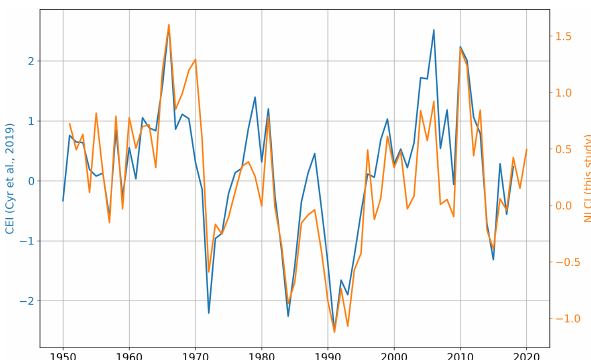
Figure 14. Comparison between the Composite Environmental In- dex (CEI) used until recently (e.g. Cyr et al., 2019) and the new NL climate index introduced here. Note the difference vertical axis sys- tems. The correlation between the CEI and the NLCI is r = 0 . 87. Note that in order to be consistent with the last version of the CEI, the NLCI based on the 1981–2010 climatology was used here. The CEI is also presented here as the average of the 28 components rather than their